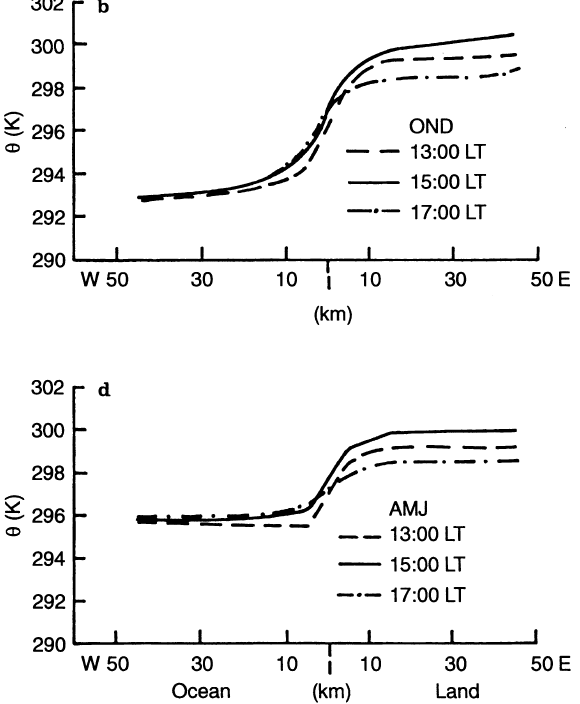
coastlineforOND; b SNvariationofpotentialtemperaturealongaline parallel to CD (Fig. 1) situated 5 km westward from the NS coastline forOND; c sameas a ,exceptforAMJ;and d sameas b ,exceptforAMJ